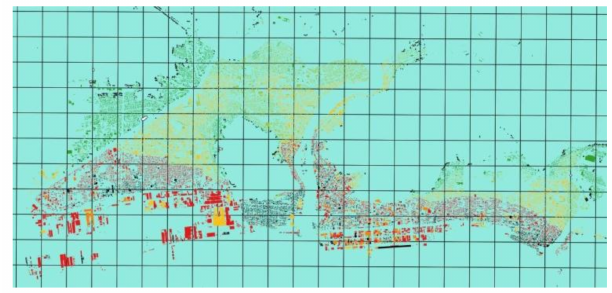
Figure 5. 500 m grid used for debris analysis overlaid on case-study location Ishinomaki.